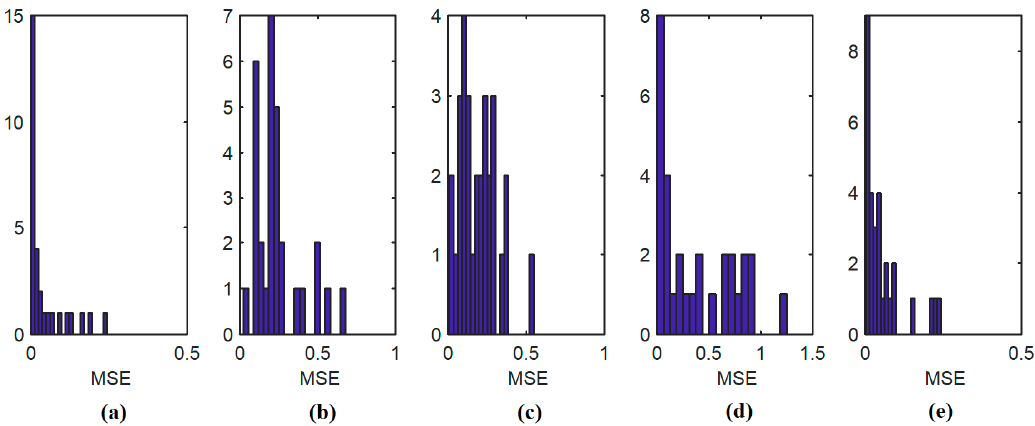
Figure 8. The distribution of noise level estimates for the entire image corresponding to 30 independent trials for each image. For each estimate, 40% of the randomly selected image patches are considered. The images: (a) Lena, (b) Town, (c) Couple, (d) Einstein, and (e) Girlface.